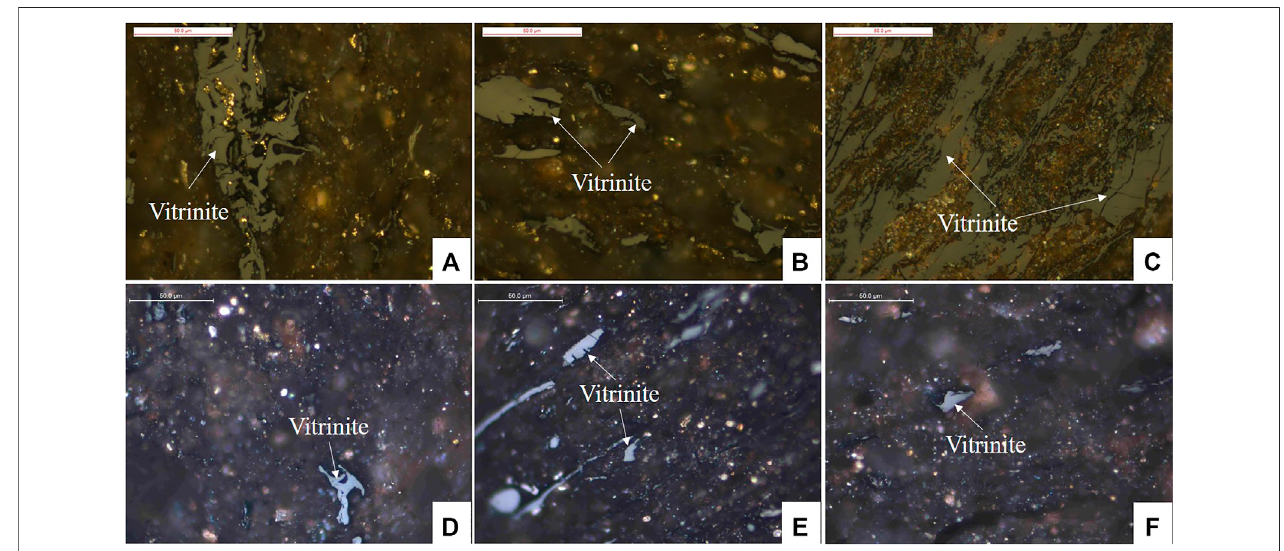
FIGURE 10 | Bulk microscopic composition of the Upper Carboniferous Keluke Formation identi fi ed by optical microscope [ (A) ZK5-2-1, (B) ZK1-1-1, (C) ZK2-1- 1, (D) QDD1-1, (E) QDD1-3, (F) QDD1-4].